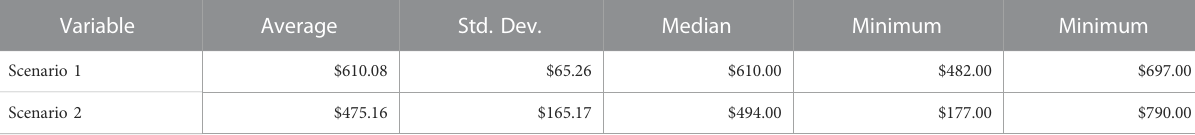
TABLE 4 Summary Statistics of Randomly Generated Annual Anhydrous Ammonia Prices Based on Different Price Series derived from the US Geological Survey (US Geological Survey) (Scenario 1) and Economic Research Service (Mosheim, 2019) (Scenario 2). Variable